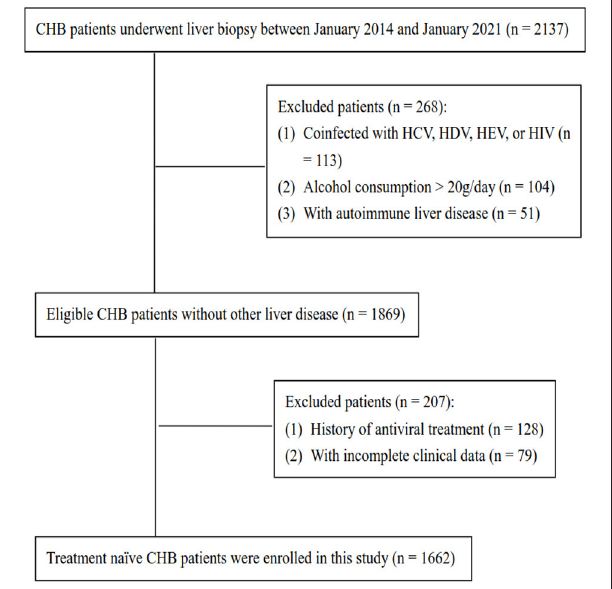
FIGURE 1 | Flow diagram of this study population. CHB, chronic hepatitis B; HCV, hepatitis C virus; HDV, hepatitis D virus; HEV, hepatitis E virus; HIV, human immunodeficiency